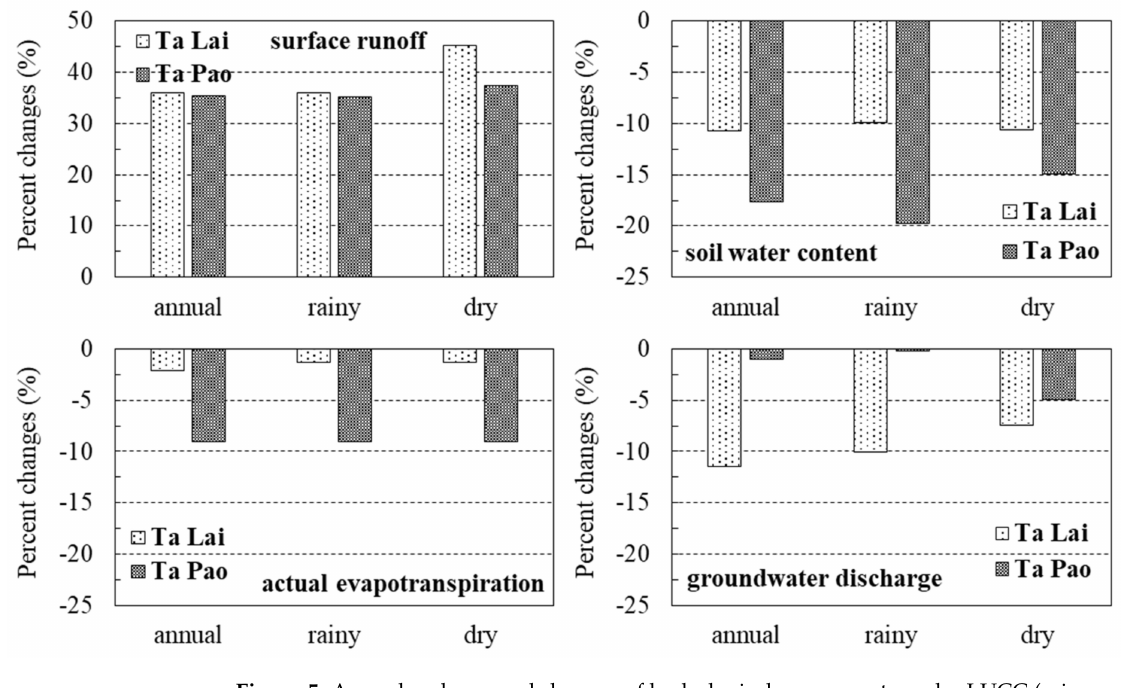
Figure 5. Annual and seasonal changes of hydrological components under LUCC (rainy season: May to October; dry season: November–April).